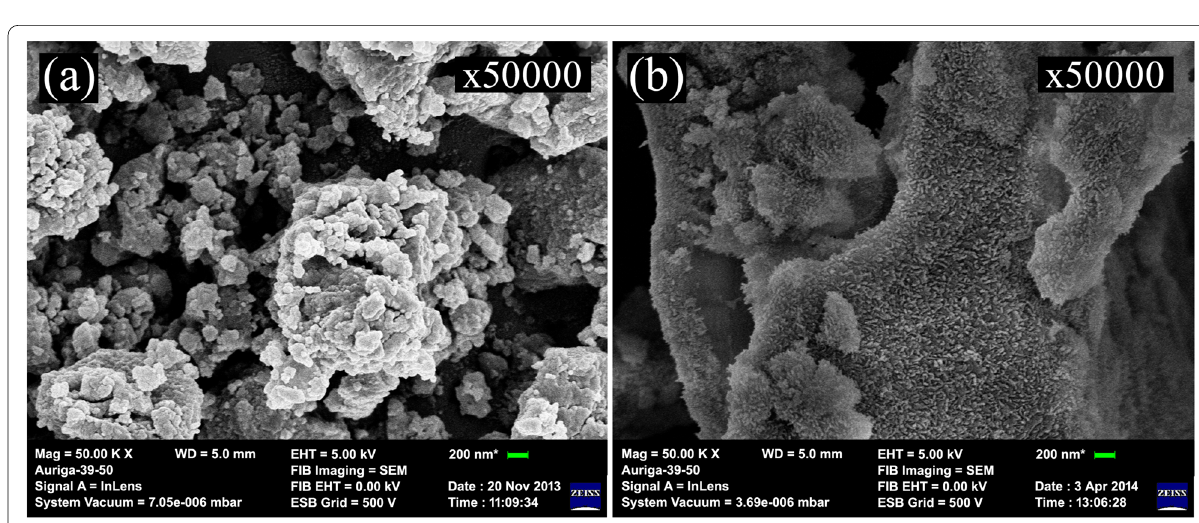
Fig. 9 The SEM of the Precipitation production (pH 0